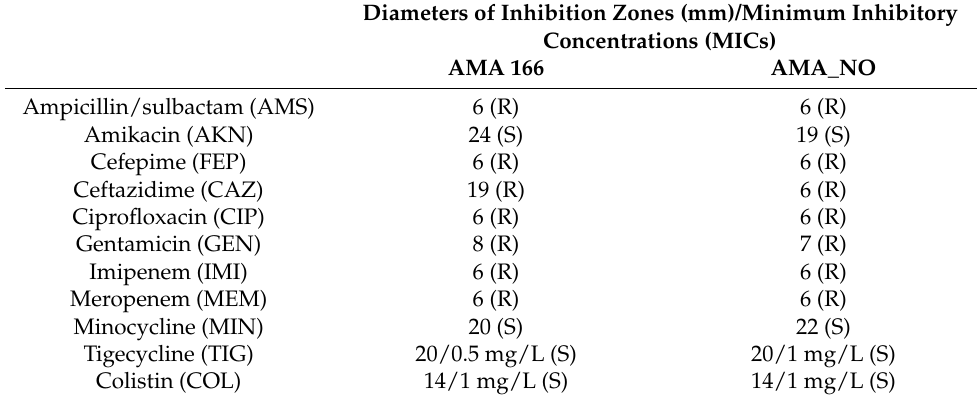
Figure 4. Expression analysis by qRT-PCR of genes coding for β -lactamases ( bla OXA-23 and bla NDM-1 ) in the AMA_NO strain. Fold changes were calculated using Δ Ct analysis. At least three independent samples were used, and four technical replicates were performed from each sample. Student’s t -test analysis was performed using GraphPad Prism (GraphPad software, San Diego, CA, USA). **: A p- value < 0.01 was considered statistically significant. Data are presented as the mean ± SD. The AMA_NO was isolated from a patient that was also infected with SARS-CoV-2. Bacterial/viral coinfections are not rare and are often synergistic, i.e., they produce en- hanced symptomatic manifestations. Numerous pairs of bacteria/viruses that act syner- gically to cause or enhance infection have been described in the literature. A